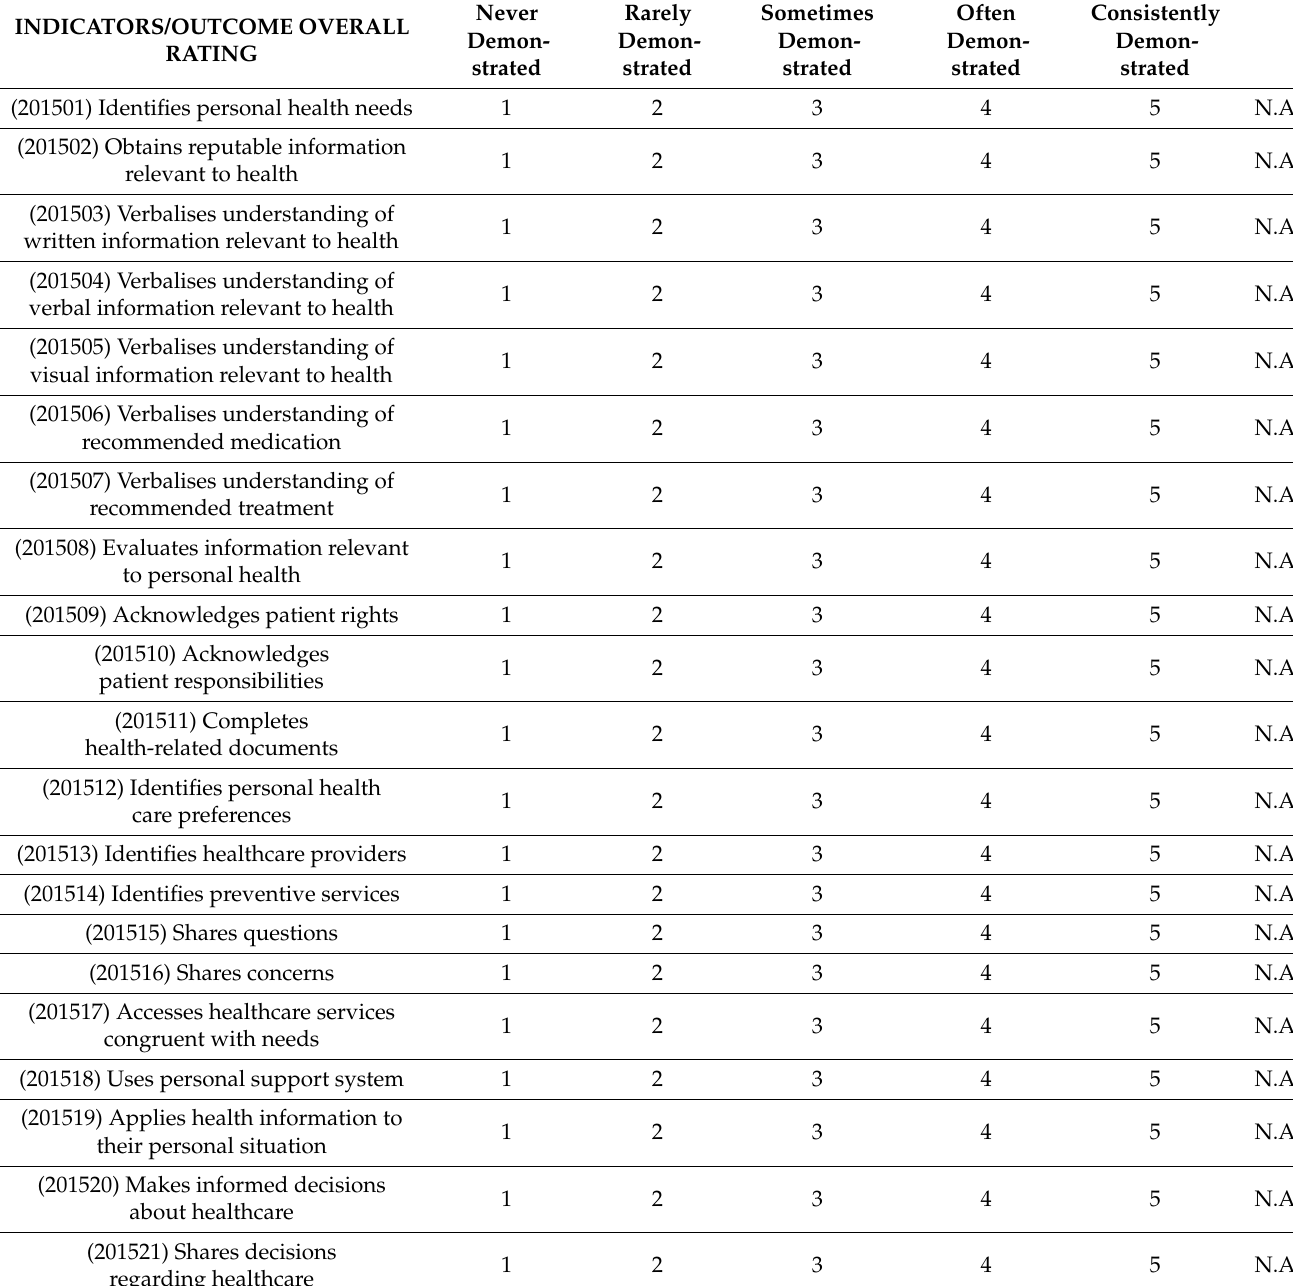
Table 1. NOC Outcome “Health Literacy Behaviour (2015)”